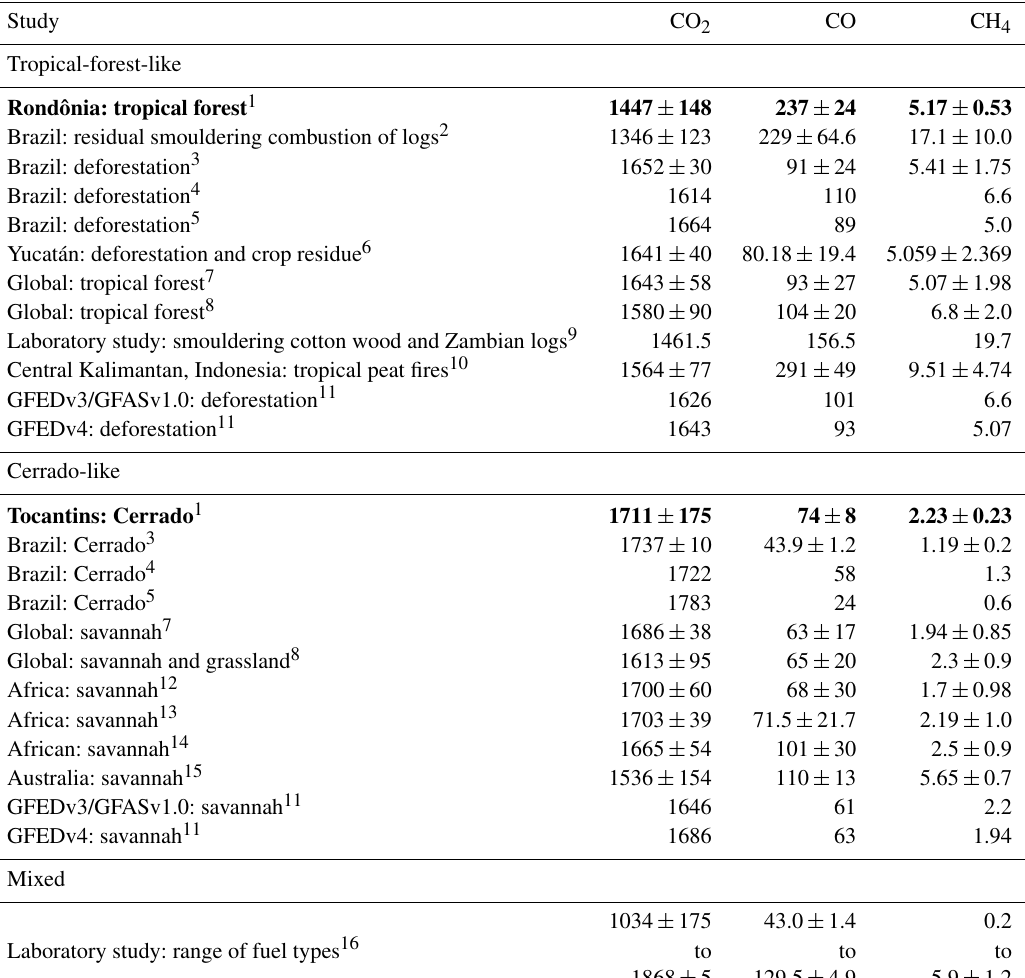
Table 3. Trace gas emission factors (gkg − 1 of dry fuel burnt) for Rondônia and Tocantins fires determined using the calculations as shown in Sect. 2.2.4. EF values from previous studies in Brazil are included for comparison with the specific fuel type stated. Also included are EFs from different geographical locations around the world and values used in GFEDv3/GFASv1.0 and GFEDv4 emission inventories (van der Werf et al., 2010; Kaiser et al., 2012). Values in bold are from this